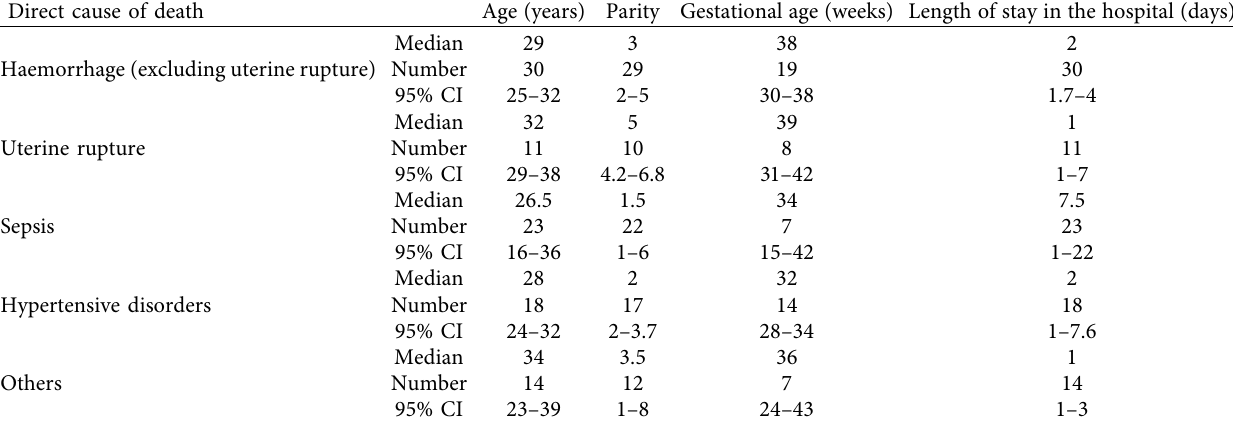
Table 2: Age, parity, gestational age, and length of stay in the hospital by direct cause of death. Direct cause of